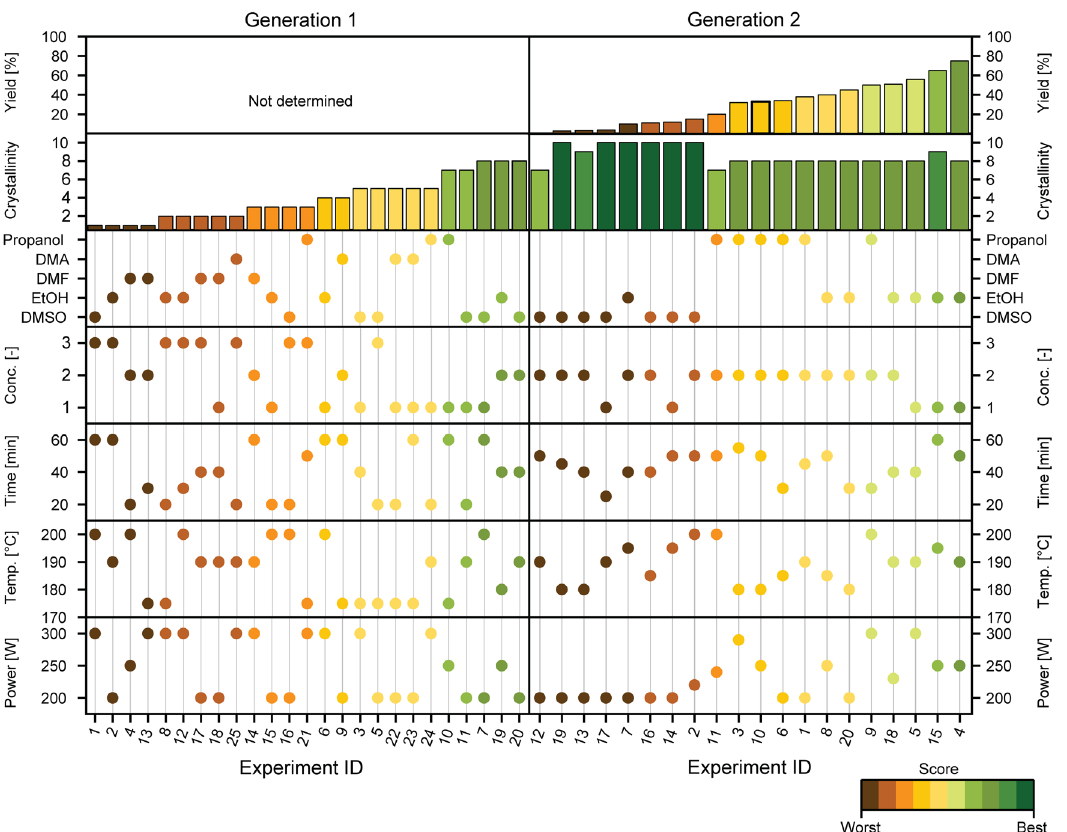
Fig. 3 Parameters and results of optimization for each synthesis of generations 1 and 2. Each experimental variable studied (i.e., microwave power, reaction temperature, time, concentration, and solvents) selected for each Al-PMOF synthesis are depicted by circles, while the bar graphs illustrate the ranking of each reaction in terms of crystallinity and yield. The color code is given for the worst (brown) and best (dark green) samples. Generation 1 was ranked in terms of the crystallinity of each sample, while the success of generation 2 was determined by the yield as all samples proved to be highly crystalline. This proves the success of the GA in providing good crystallinity of all samples in just one generation. The PXRD patterns and N 2 isotherms at 77 K can be visualized at https://www.cheminfo.org/ fl avor/zenodo/index.html?id = &id = 7186602.